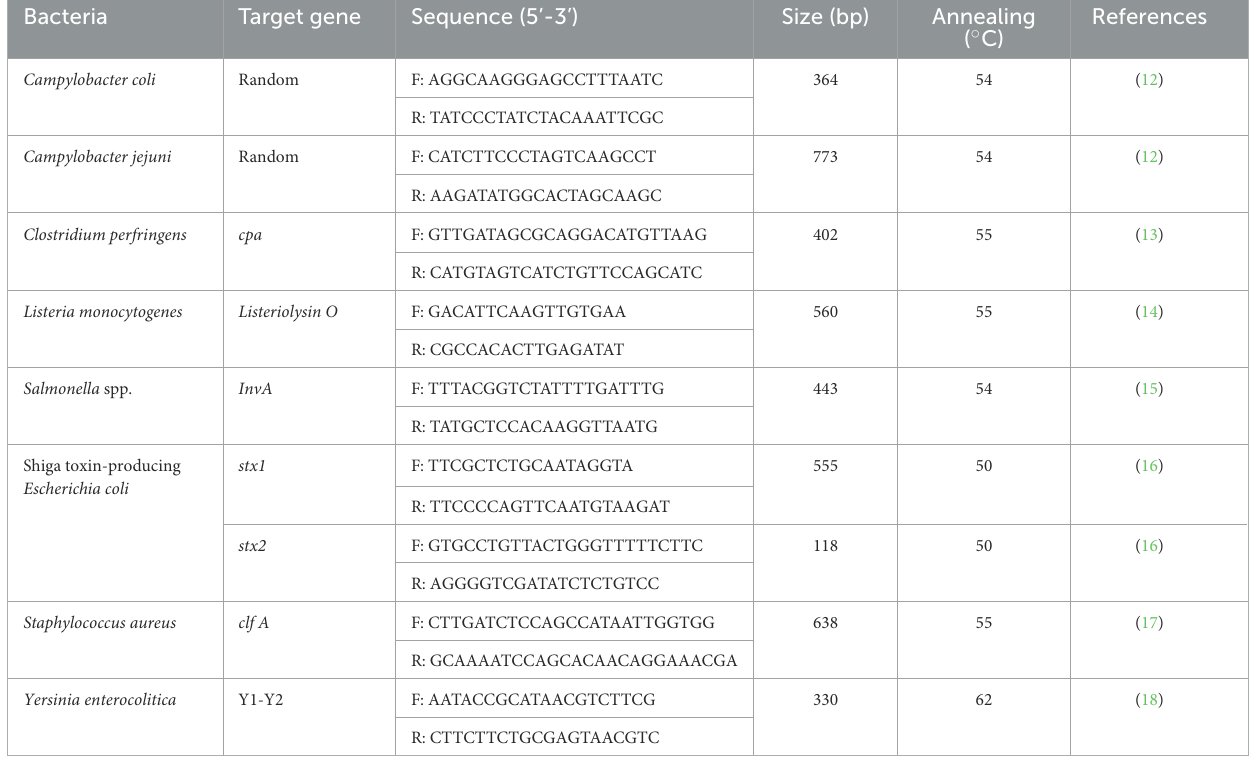
TABLE 1 Primer sequences used in this